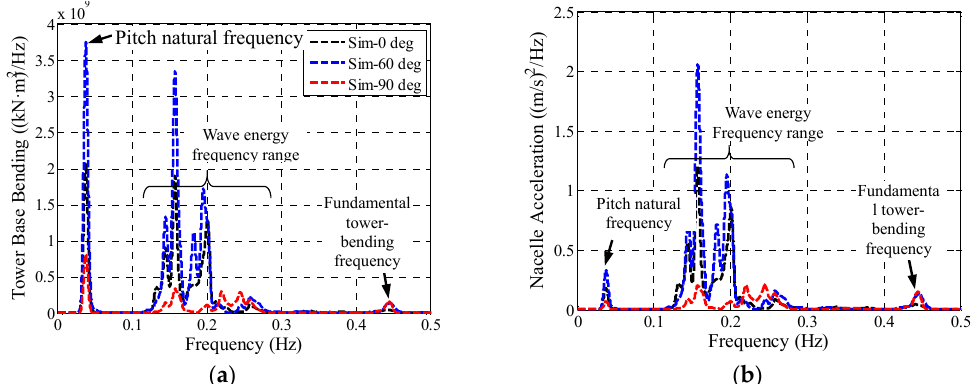
Figure 20. Comparisons of ( a ) tower base fore-aft bending and ( b ) nacelle acceleration PSD in three wave